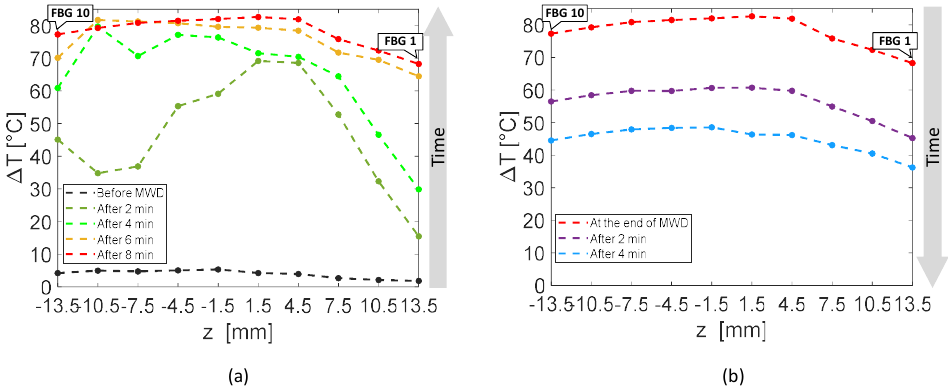
Figure 10. Temperature variations recorded by the ten FBGs of array A 4 versus space along the axis of the array, parallel to the z -axis: ( a ) rising temperature profiles recorded every 2 min, starting before the antenna activation to the end of the MW discharge (MWD), which happened 8 min later; ( b ) decreasing temperature profiles starting from the antenna shutdown and recorded 2 min and 4 min later.